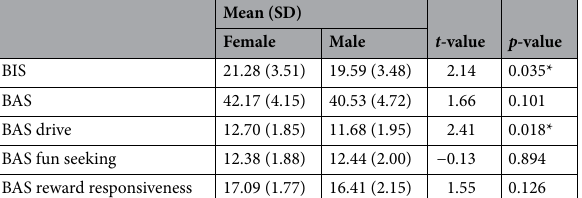
Table 1. Means (standard deviations) and statistics of behavioral inhibition system (BIS) and behavioral activation system (BAS) scales. P -values with an asterisk indicate